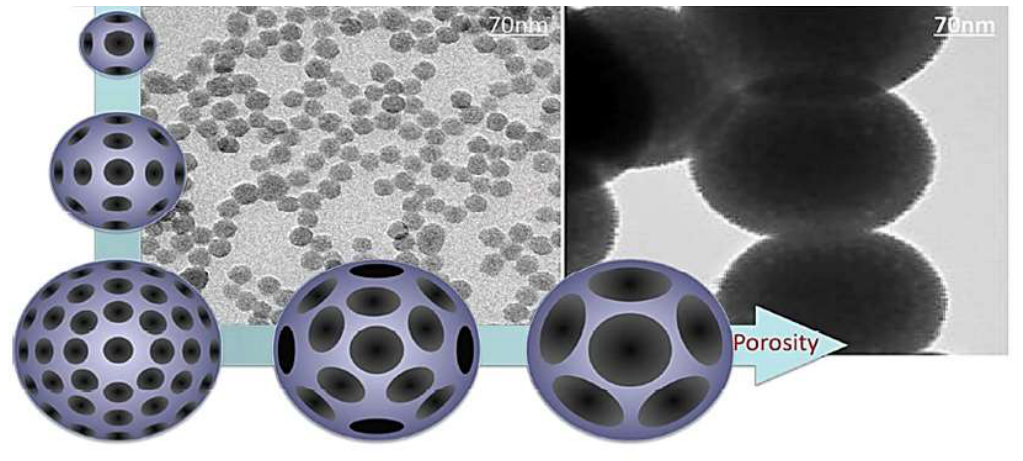
Figure 7: Nano-structured meso-porous material